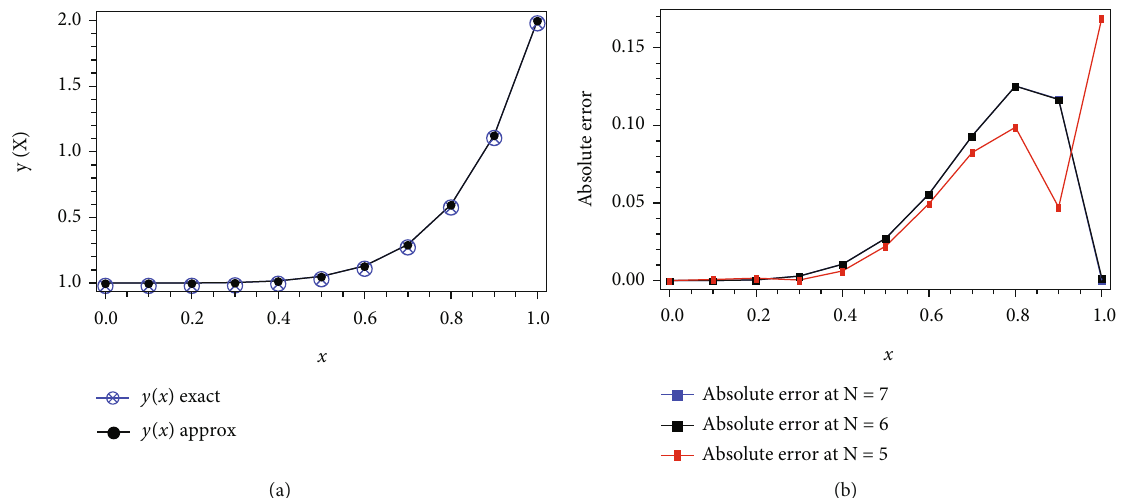
Figure 5: Exact solution and numerical solutions (a), absolute error (b) for Example 4 with di ff erent values of N and h = 1 in case of h = 1 .